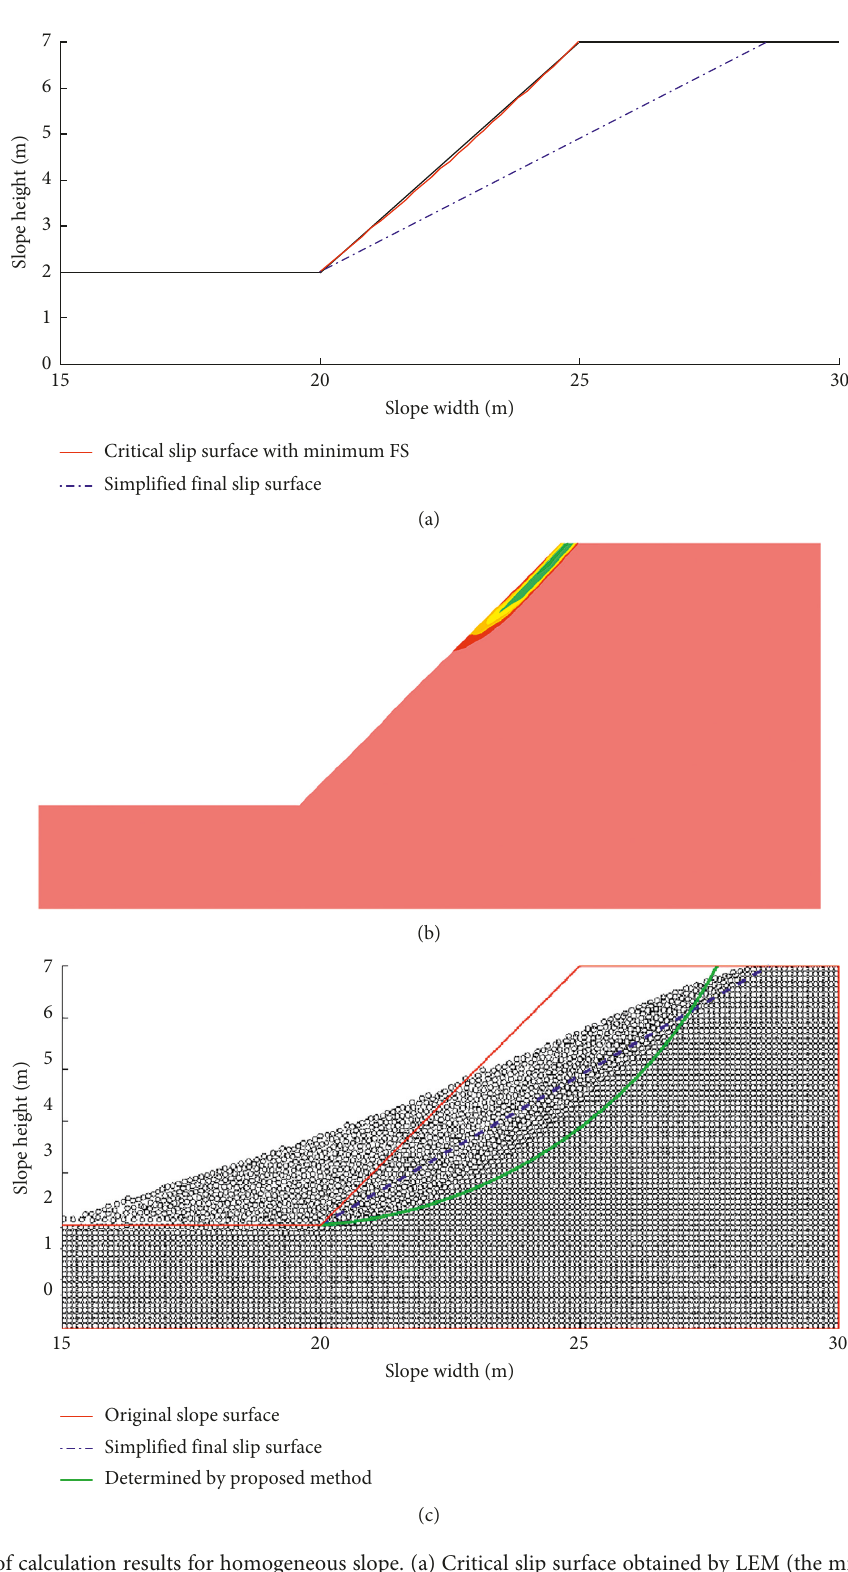
0.58). (c) Comparison of slip surfaces obtained by slope deposit (cid:31)